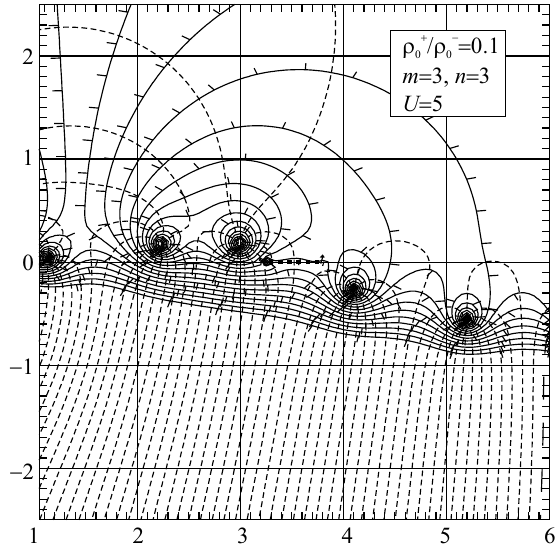
Fig. 9. Transmission coefficient in the complex plane when the effect of the resonance is taken into account and the magnetosheath plasma is in motion. The full contours represent amplitude with the Fig. 8. Reflection coefficient in the ticks showing the downhill direction. The contours are drawn for log | R |= 0 . 1 n where n = 0 , ± 1 , ± 2 , ± 3 ,... . The heavy dotted line complex plane when the magnetopause is a branch cut. The dashed lines are contours of constant phase plasma is in motion. The lower panel drawn at 30 ◦ shows the detail of a portion of the up- per panel. The full contours represent amplitude with the ticks showing the downhill direction. The contours are drawn for log | R | = 0 . 1 n where n = 0 , ± 1 , ± 2 , ± 3 , . . . . The heavy dotted line is a branch cut. The dashed lines are contours of constant phase drawn at 30 ◦ intervals.